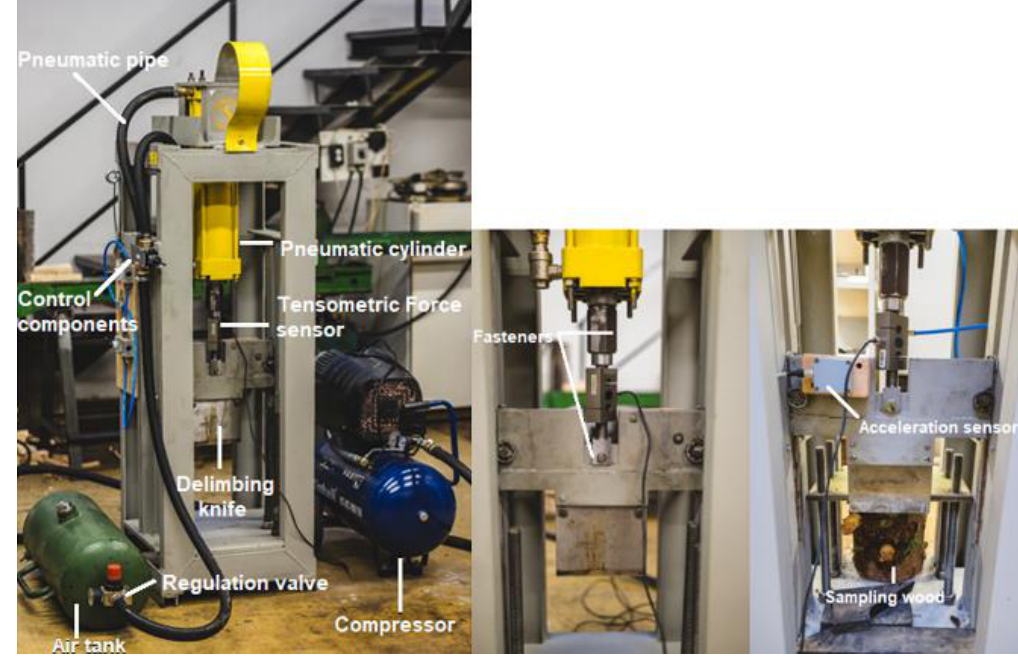
Figure 1. Experimental device for the chipless delimbing wood cutting process and the application of sensors to the arrangement of the device and their fastening .